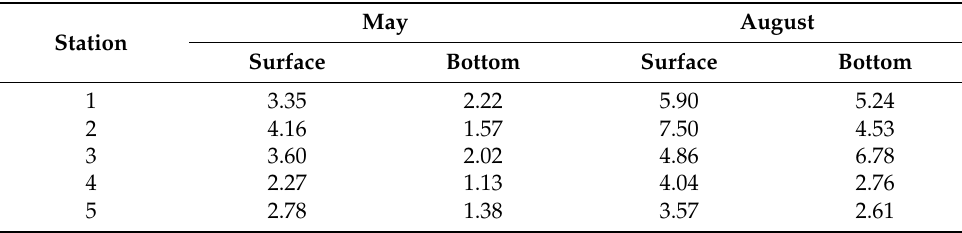
Table 4. Eutrophication index (E) in Tongyeong Sanyang-eup during the study period. The index was calculated as E = (COD × DIN × DIP)/3.43, where COD is chemical oxygen demand, DIN is dissolved inorganic nitrogen, and DIP is dissolved inorganic phosphate [43,44].